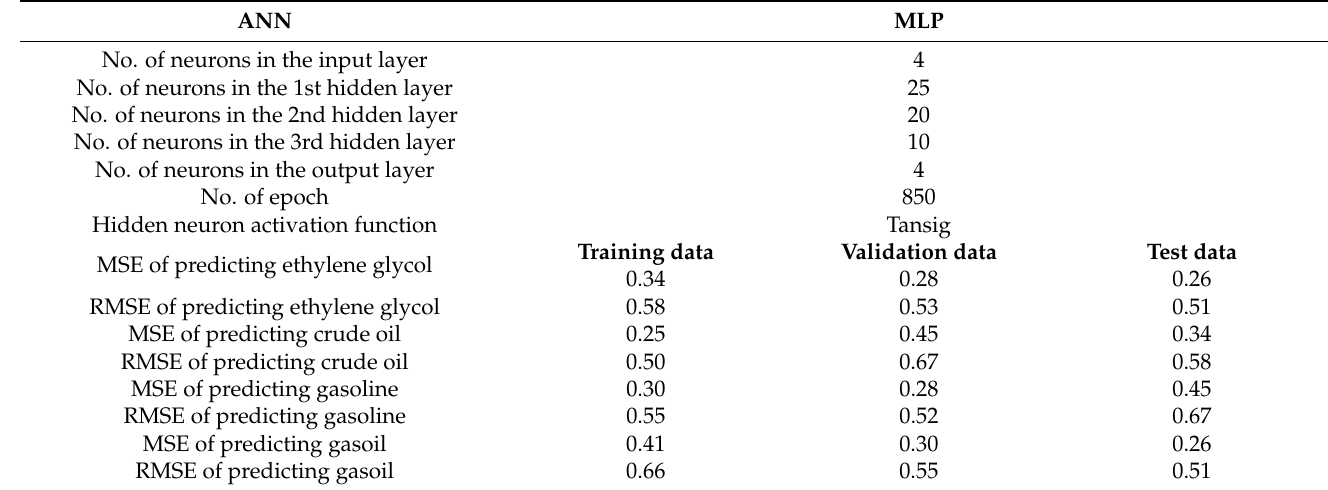
Figure 8. Network performance for predicting the volume rate of gasoil: ( a ) training, ( b ) validation, and ( c ) testing dataset. Table 1. The characteristics of designed networks.